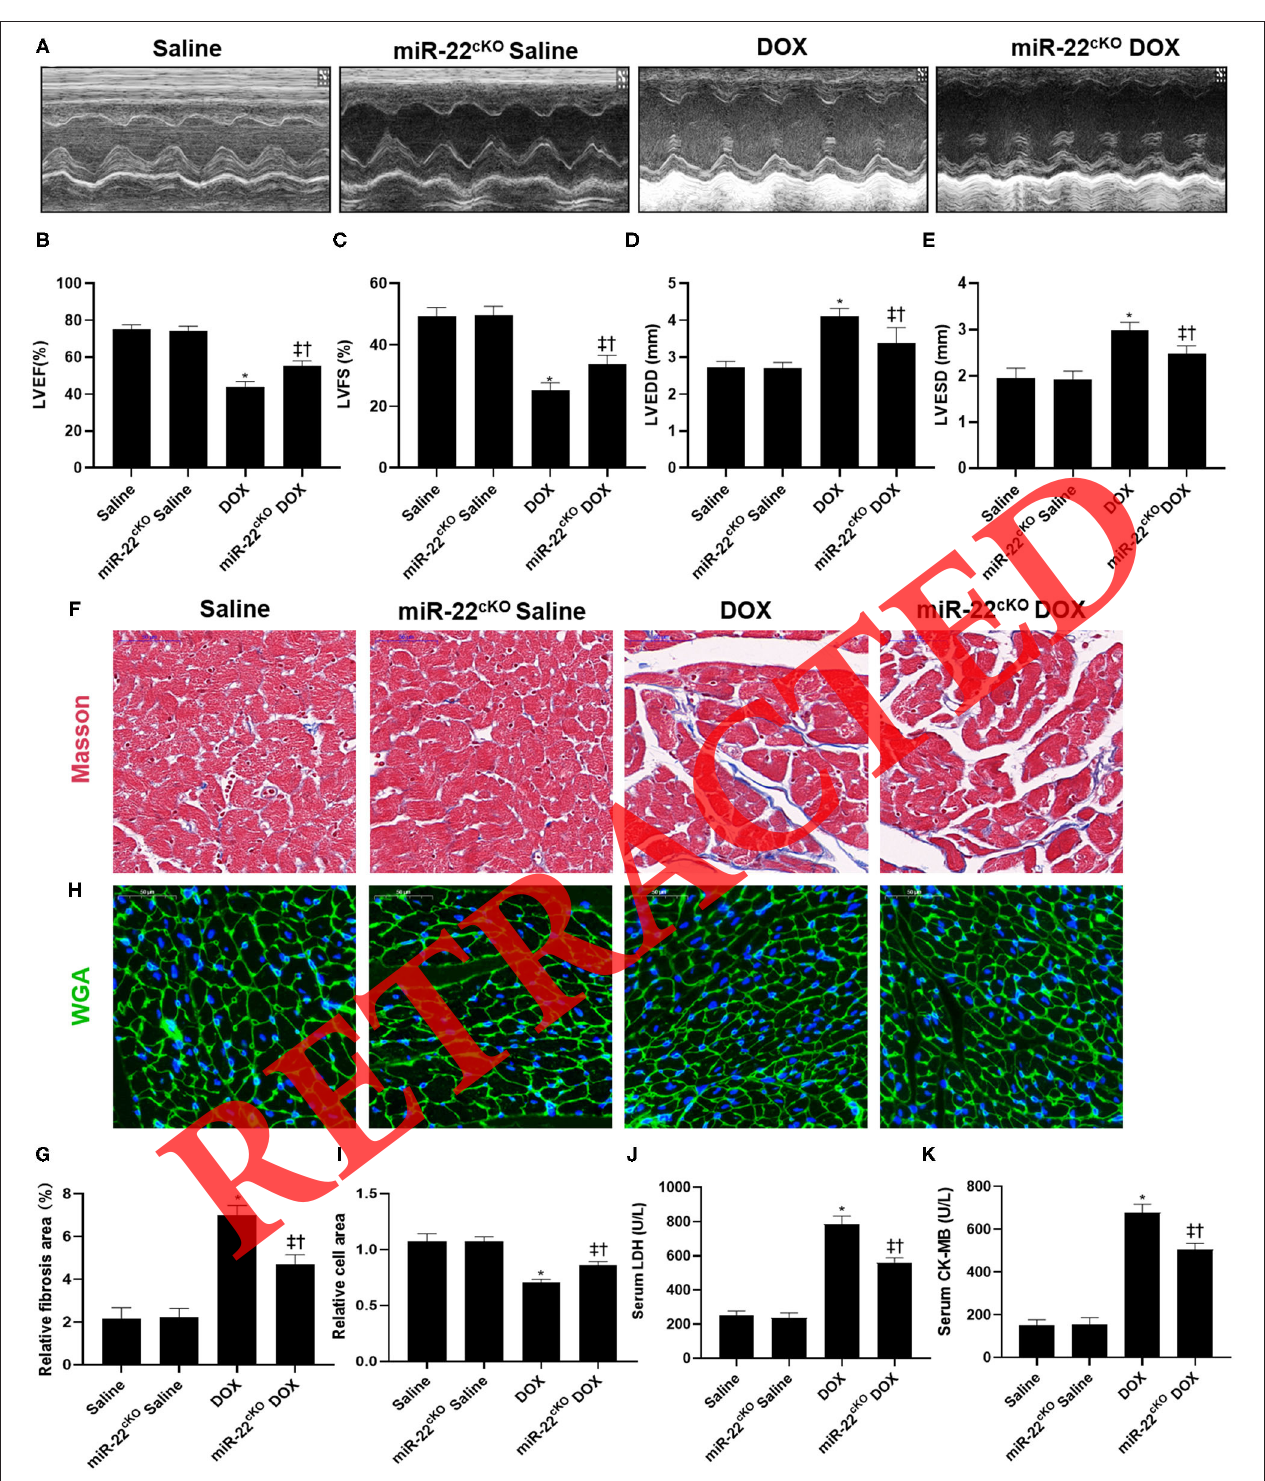
FIGURE 1 | Knocking out miR-22 alleviates cardiac dysfunction in DOXIC. (A) M-mode Echocardiograms representative image ( n = 6), (B) LVEF, (C) LVFS, (D) LVESD, (E) LVEDD, (F) Representative images of Masson staining, (G) Relative collagen area, (H) Representative WGA staining images, (I) Relative cell area, (J) serum LDH ( n = 6), (K) serum CK-MB ( n = 6), Data were shown as mean ± SEM. * P < 0.05 vs. saline group, ‡ P < 0.05 vs. DOX group, † P < 0.05 vs. miR-22 cKO group.